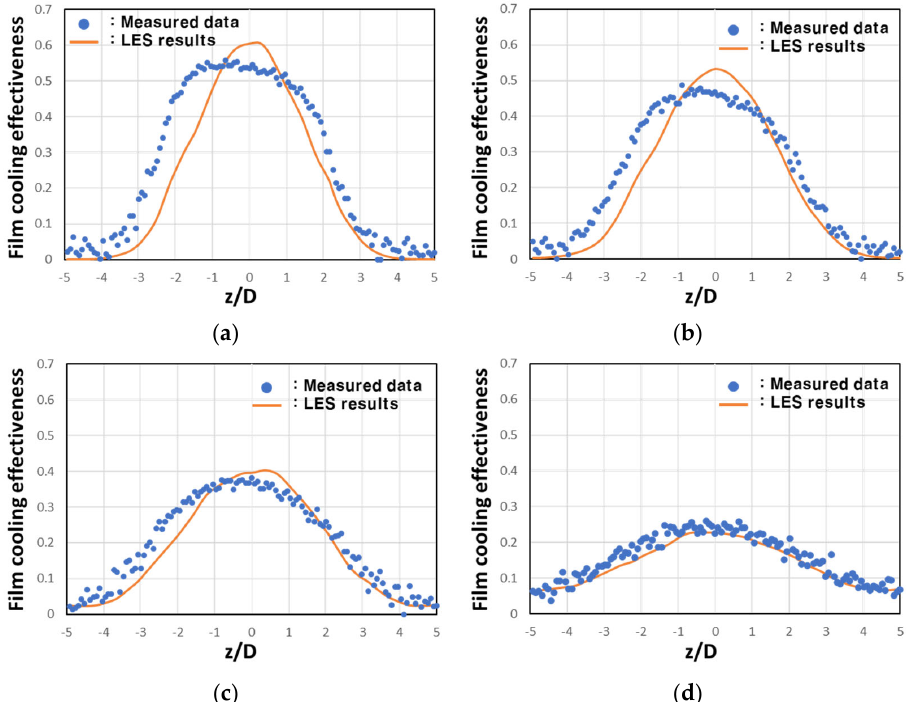
Figure 15. Lateral film cooling effectiveness distributions at ( a ) x/D = 2, ( b ) x/D = 5, ( c ) x/D = 10, and ( d ) x/D = 20 when the blowing ratio is 2.0.